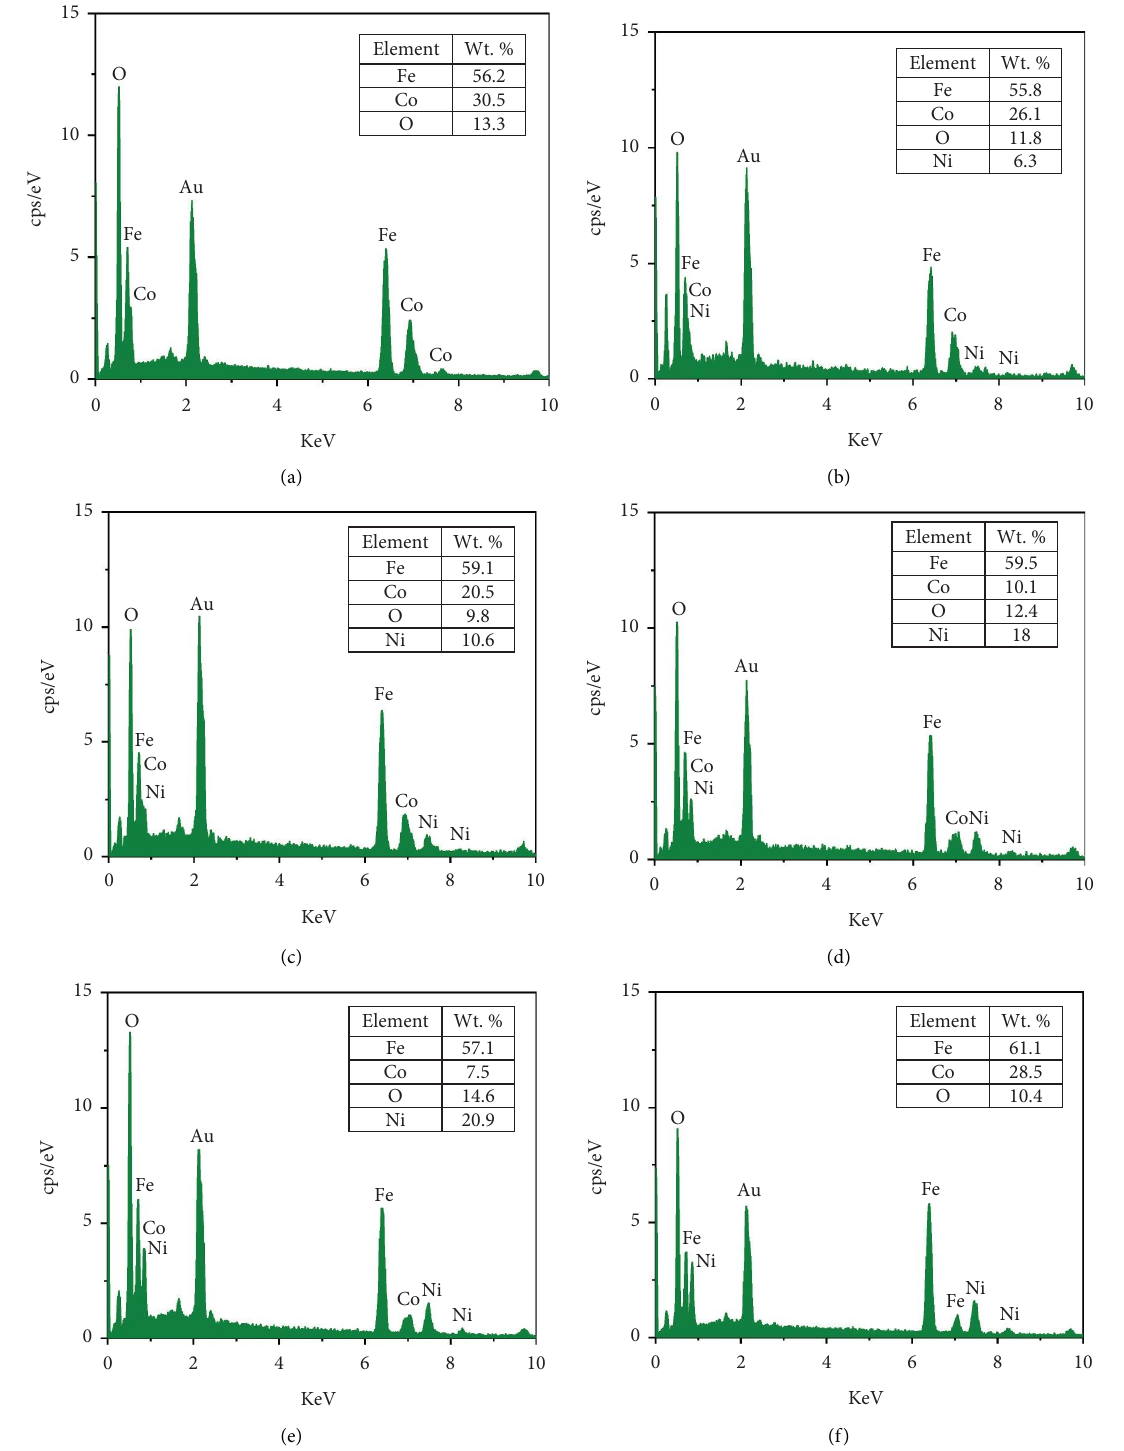
Figure 11: Elemental weight composition of nickel-substituted cobalt ferrite: (a) x � 0.0, (b) x � 0.2, (c) x � 0.4, (d) x � 0.6, (e) x � 0.8, and (f) x �